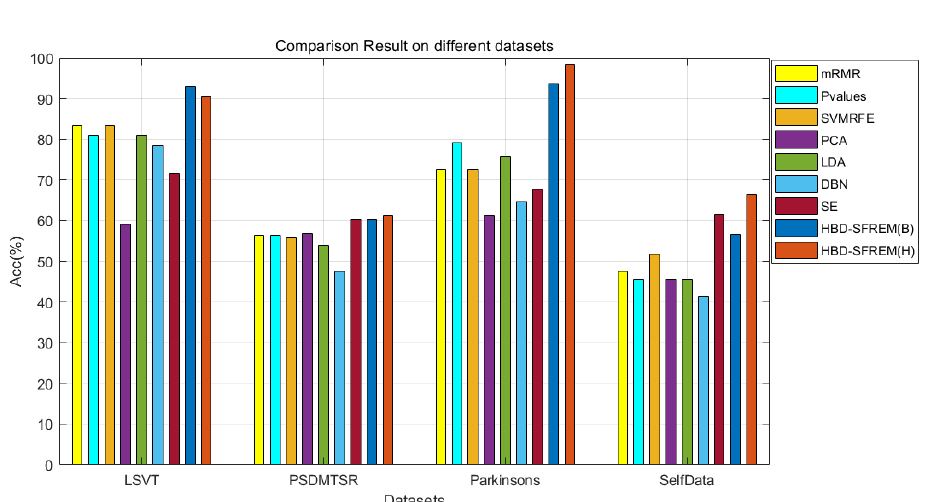
Figure 3. Comparison Results Using Different Datasets.